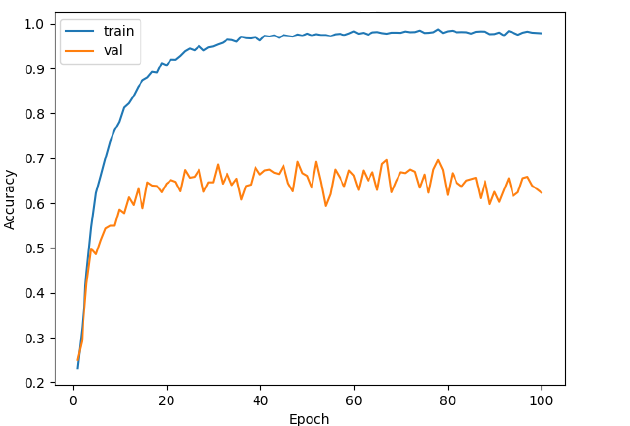
Figure 12. The accuracy of DEMON and VGG